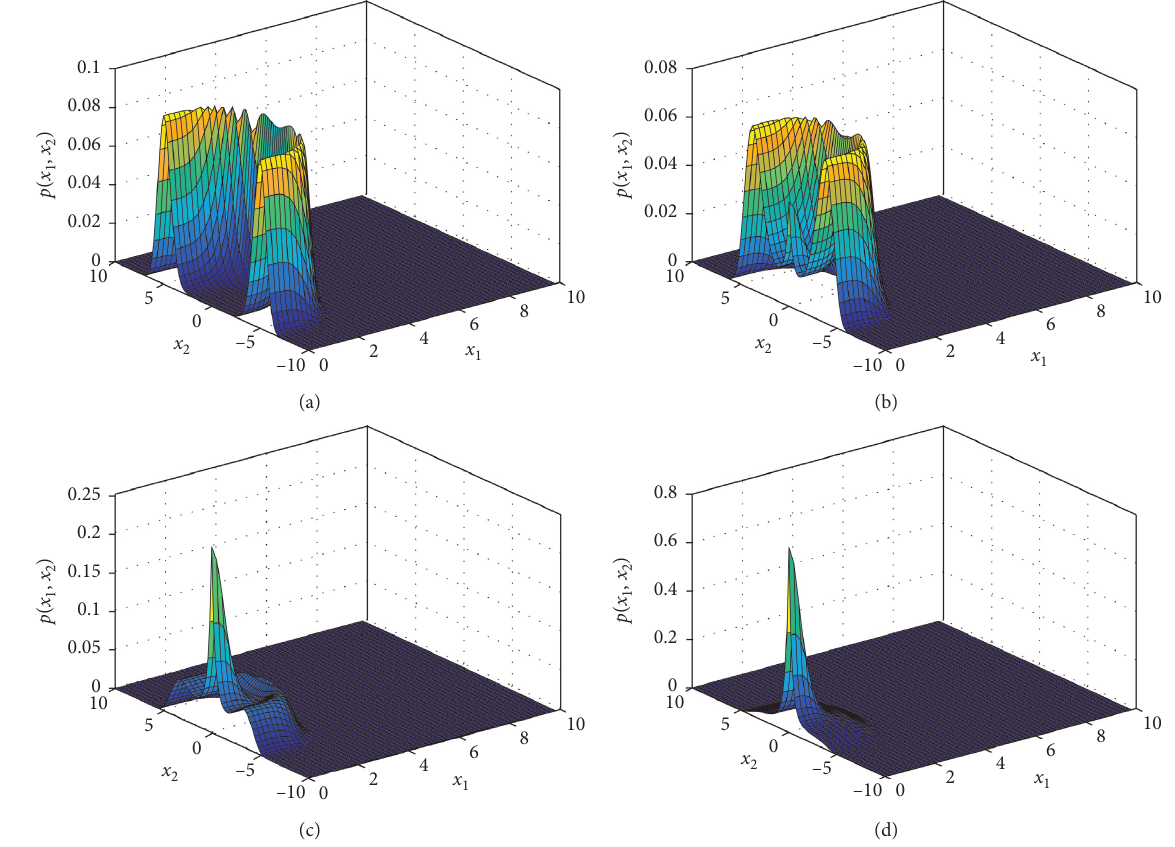
Figure 9: Analytical results of stationary joint PDFs for displacement x (b) f k � 2, (c) f k � 2 . 5, and (d) f k � 3.